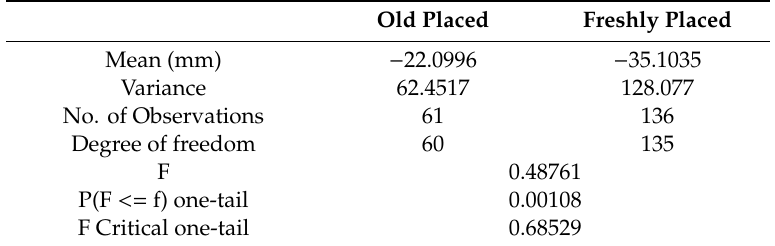
Table 10. F-Test two-sample for variances of old placed vs. wave exposed rockfill internal zones. Old Placed Wave Exposed Mean (mm)